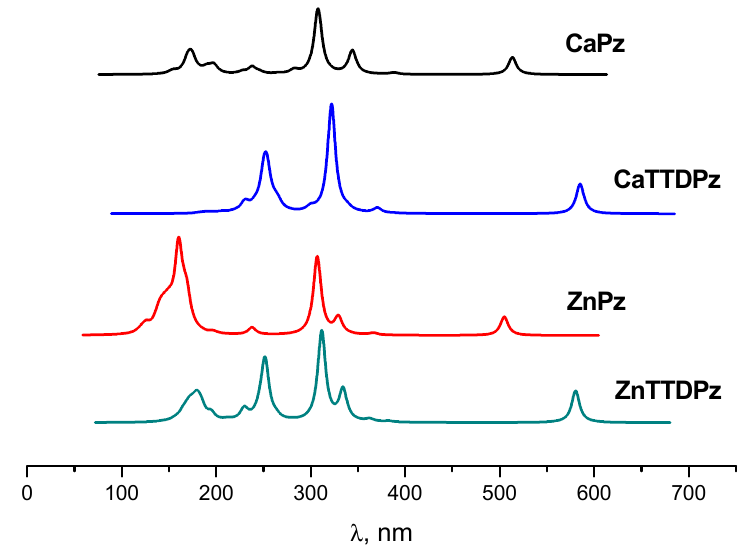
Figure 7. Calculated TDDFT electronic absorption spectra for MPz and MTTDPz Figure 7 . Calculated TDDFT electronic absorption spectra for MPz and MTTDPz complexes.